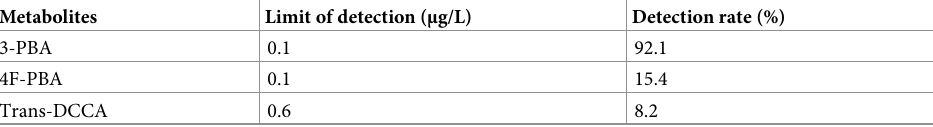
Table 1. Detection rates of urine pyrethroid metabolites among participants, NHANES